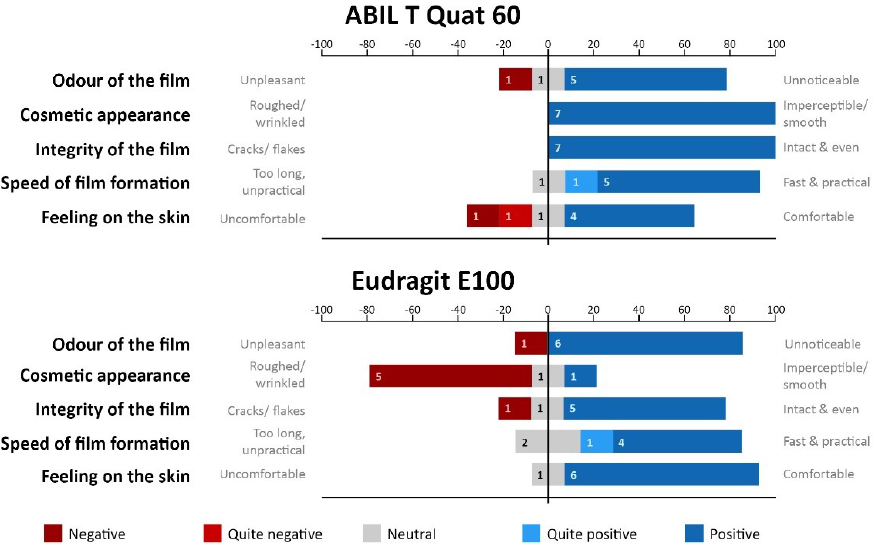
Figure 9. Acceptability of ABIL and Eudragit polymeric films as described by the participants’ ( n = 7) answers to a questionnaire. The scoring system is based on a Likert scale.